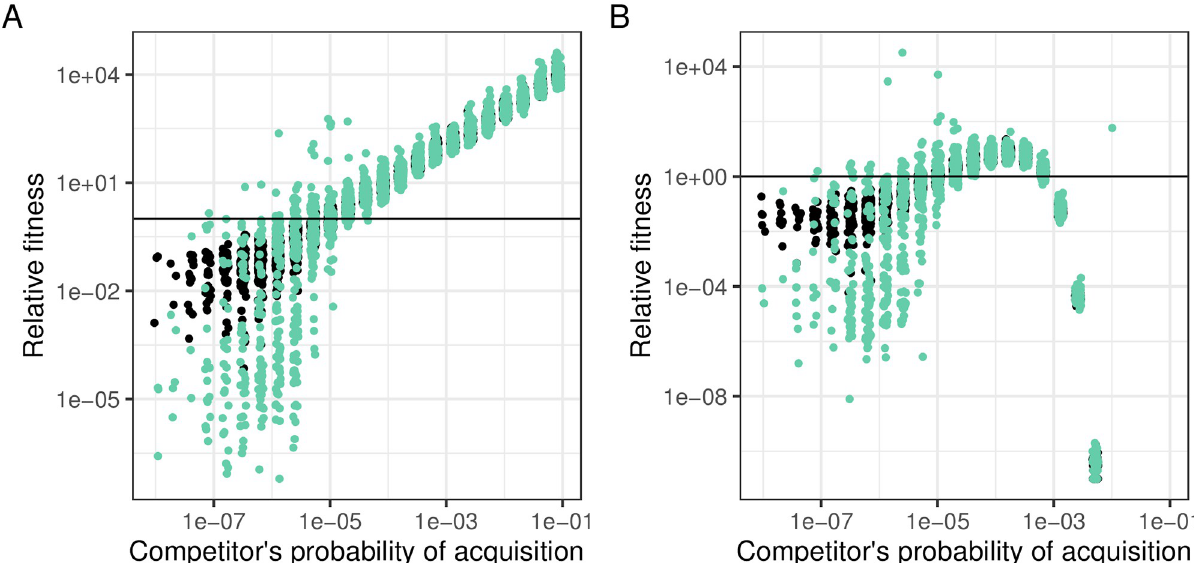
Fig 4. Fitness of a bacterial strain across a range of probabilities of spacer acquisition when in competition with a strain with a probability of spacer acquisition α = 10 − 5 in the absence of autoimmunity (A) and in the presence of autoimmunity(B). Colours correspond to the type of CRISPR-Cas immune systems: in black, type III CRISPR-Cas systems ( μ = 0) and in green, type I/II CRISPR-Cas systems ( μ = 3.4 � 10 − 7 ) All simulations were run with Propensity = 40. Each point corresponds to one simulation. Only simulations in which bacteria survive the infection have been